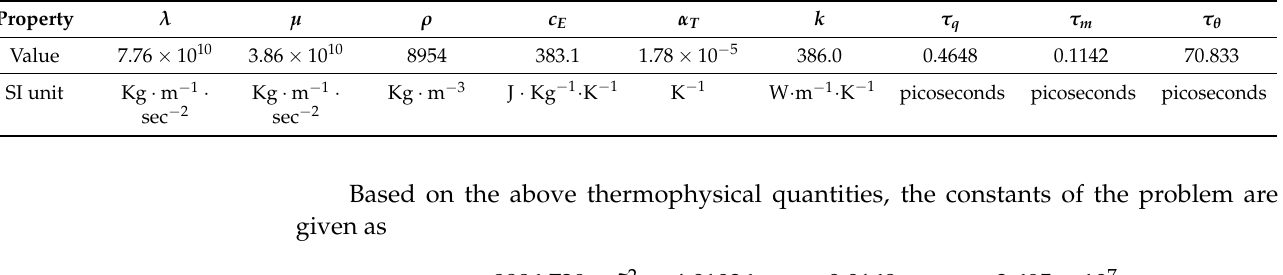
Table 1, the values are taken from [26,37,46]: Table 1. Material parameters for copper at room temperature T 0 = 293 ◦